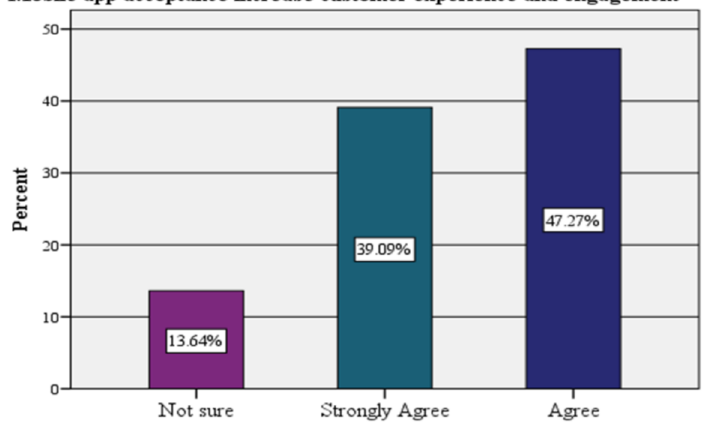
Figure 6. Effects of mobile app acceptance on customer experience and